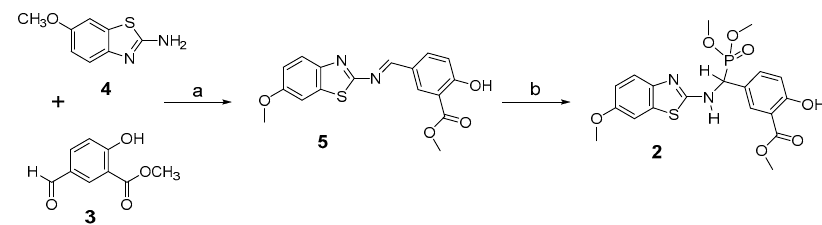
Figure 2. Chemical synthesis of nonsteroidal 17 β -hydroxysteroid dehydrogenase type 10 (17 β -HSD10) inhibitor 2 . Reagents and conditions: (a) Mg(ClO 4 ) 2 , toluene, reflux, 66 h; (b) HPO(OCH 3 ) 2 , toluene, reflux, 22 h.